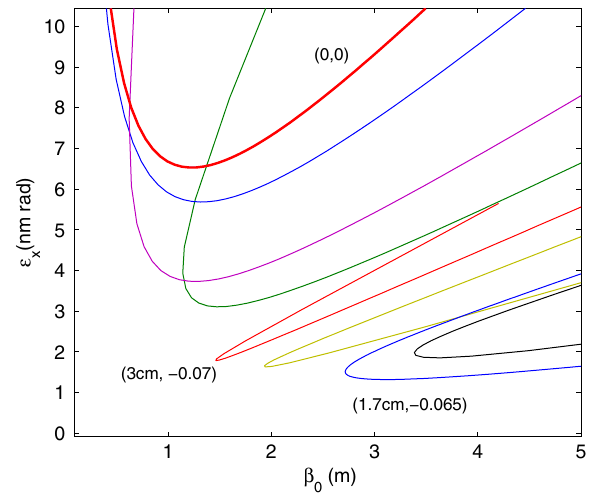
FIG. 3. Horizontal natural emittance (cid:3) x of the ALS storage ring as a function of (cid:4) The different curves represent different pairs ð (cid:5)